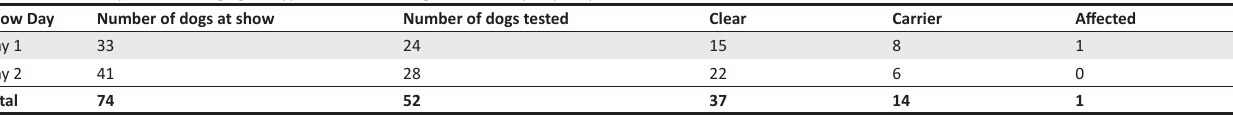
FIGURE 1: A graphical demonstration of canine degenerative myelopathy heritage in a South African Boxer dog family. TABLE 2: Summary of Boxer dogs genotyped for canine degenerative myelopathy. Show Day Number of dogs at show